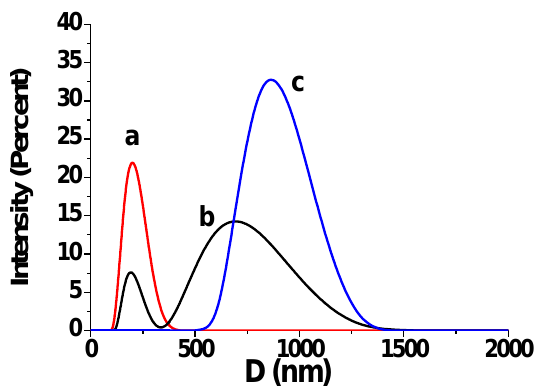
Figure 9. DLS particle size distribution by intensity in retentate of the GSI experiment for K = 1 (a), K = 2 (b) and K = 3 (c).